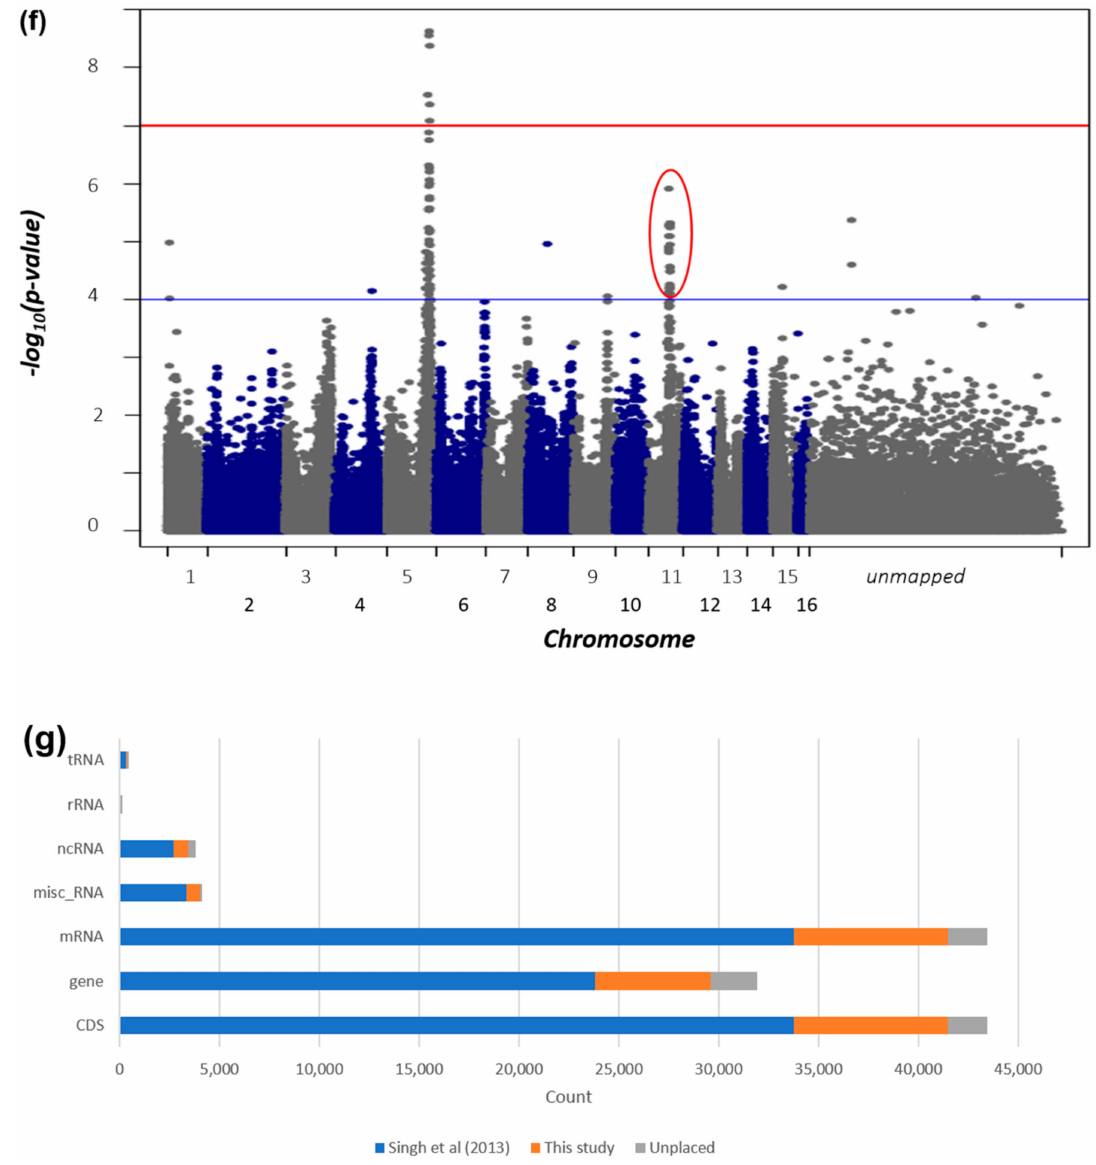
Figure 1. Refined assembly of oil palm genome (PMv6). ( a ) Chromosome length (Mb) comparison between P5-build, Singh et al., (2013), and PMv6 (this study). ( b ) Number of sca ff olds from previous physical map [22]) and the improved physical map developed in this study. ( c ) Buildup of PMv6 by sca ff old anchoring using multiple linkage maps; left panel represents the central combined linkage map from three mapping populations, and the right panel shows the correlation plots of each populations’ genetic versus physical order; presented in the order of Deli dura × Nigerian dura ( dura 1—green), Johore Labis dura ( dura 2—orange), and Deli dura × AVROS pisifera ( tenera —blue) for Chromosome 2 and ( d ) Chromosome 7 as examples. ( e ) Genome-wide association studies (GWAS) Manhattan plot for a commercial oil palm population for one of the oil yield trait [23] for the genome published by P5-build. ( f ) GWAS Manhattan plot for the same commercial oil palm population for one of oil yield trait after assembly improvement in this study, circle in red represent newly assigned and significant SNPs. ( g ) Statistics of genomic features improvement after placement of sca ff olds into chromosomes for P5-build and this